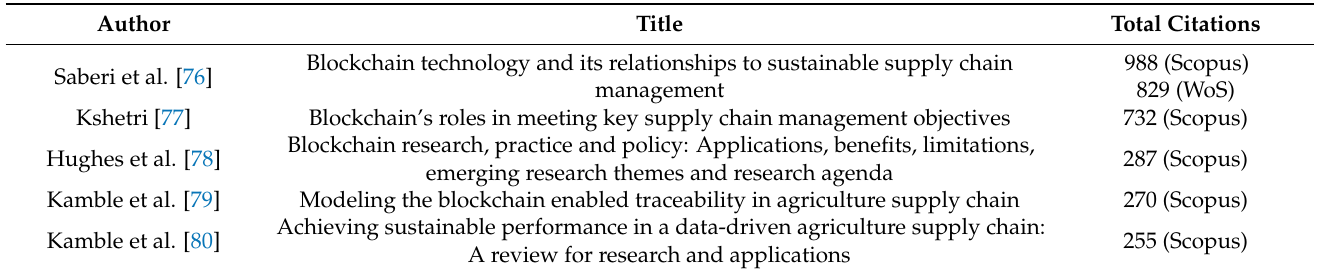
Table 3. Top Five Most Cited